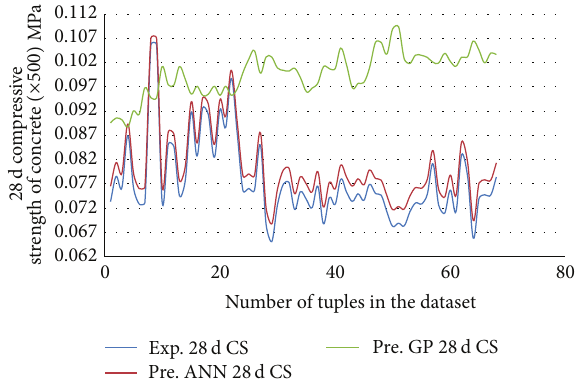
Figure 7: Validation of the proposed model of 28 d compressive strength of concrete with in situ dataset as per